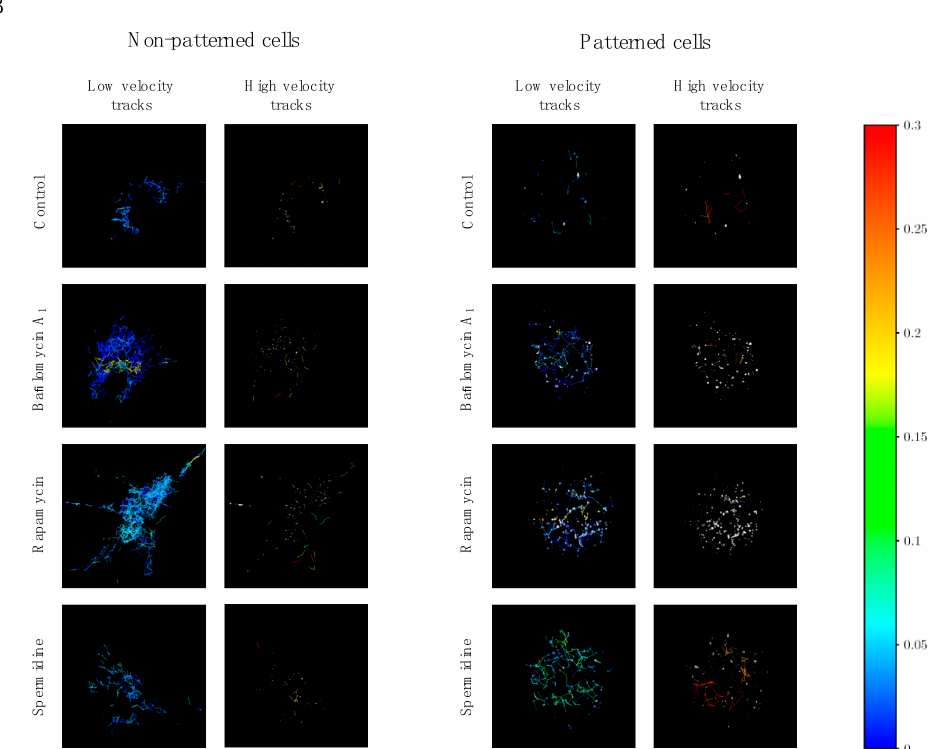
Figure 4. Autophagosome velocity and displacement analysis ( A ) in patterned and non ‐ patterned cells upon autophagy induction, using rapamycin or spermidine, as well as partial inhibition, using non ‐ saturating concentrations of bafilomycin. Representative micrographs of low and high velocity tracks ( B ) are indicated. A minimum of three independent experiments ( n = 3) were performed.